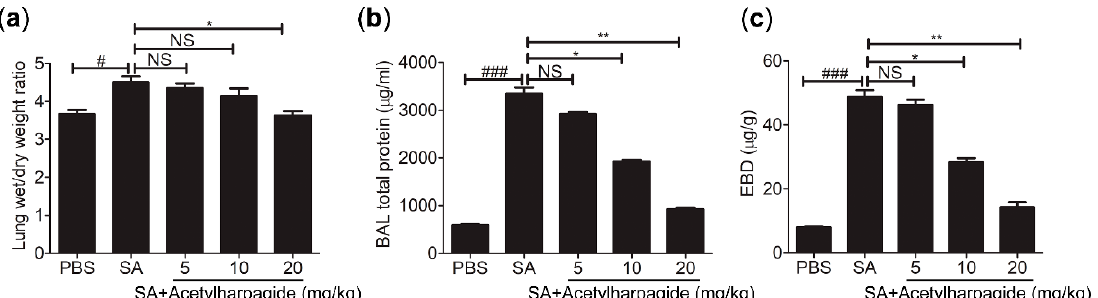
Figure 3. Acetylharpagide relieved S. aureus (SA)-induce pulmonary vascular permeability and edema. ( a ) The lung wet / dry ratio was detected at 12 h after S. aureus infection; ( b ) Bronchoalveolar lavage (BAL) fluid was collected at 12 h after S. aureus infection and bicinchoninic acid (BCA) protein assay was performed to measure the total protein concentration; ( c ) The concentration of evans blue dye (EBD) in the lung tissue was examined at 12 h after S. aureus infection. The data were presented as mean ± SD, # p < 0.05, ### p < 0.001 vs. PBS + DMSO group, * p < 0.05, ** p < 0.01 vs. SA + DMSO group, n = 6–8.